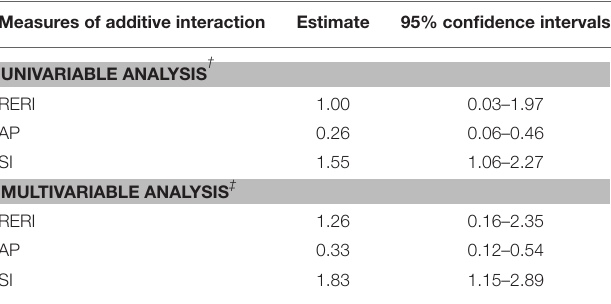
TABLE 3 | Additive interaction between height < 158cm and BMI ≥ 24 kg/m 2 for the risk of gestational diabetes mellitus. Measures of additive